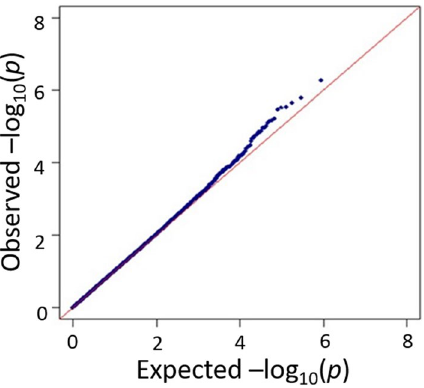
Figure 3. Quantile–quantile plot of AESD GWAS after whole-genome imputation. Quantile–quantile plot of p -values for each SNP calculated based on allelic model. The inflation factor was less than